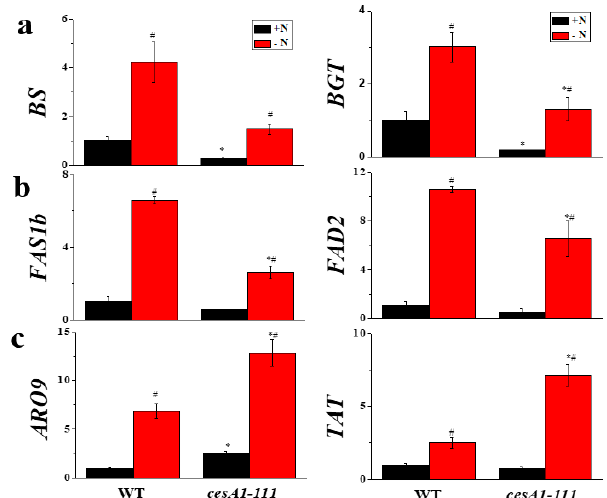
Figure 4. Transcript levels of genes for the biosynthesis of chrysolaminarin ( a ), cytosolic fatty acids and lipids ( b ), and amino acids ( c ) in N. salina wild-type (WT) and cesA1 mutant grown under + N and − N conditions for 3 d. BS , 1,3- β -glucan synthase; BGT , β -1,3-glucosyltransferase; FAS1b , type I fatty acid synthase; FAD2 , ∆ 12 desaturase; TAT , tyrosine aminotransferase; ARO9 , aromatic amino acid aminotransferase. Gene expression (2 − ∆∆ Ct ) was normalized to that of the housekeeping gene, ubiquitin. Each data point represents the mean ± SE of three biological replicates performed in triplicate. The symbols represent statistically significant differences ( p ≤ 0.05) between mutants vs. WT (*), and between +N and − N cells (#), accordingly.